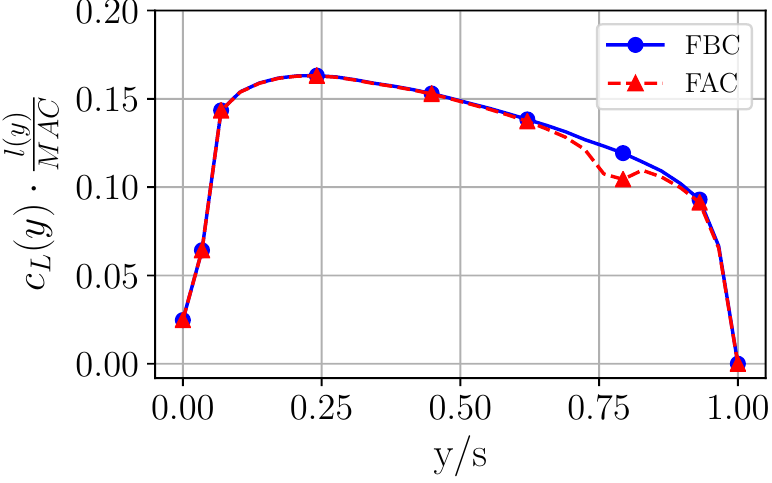
Figure 24. Comparison of steady-state wing loads for the FBC and the